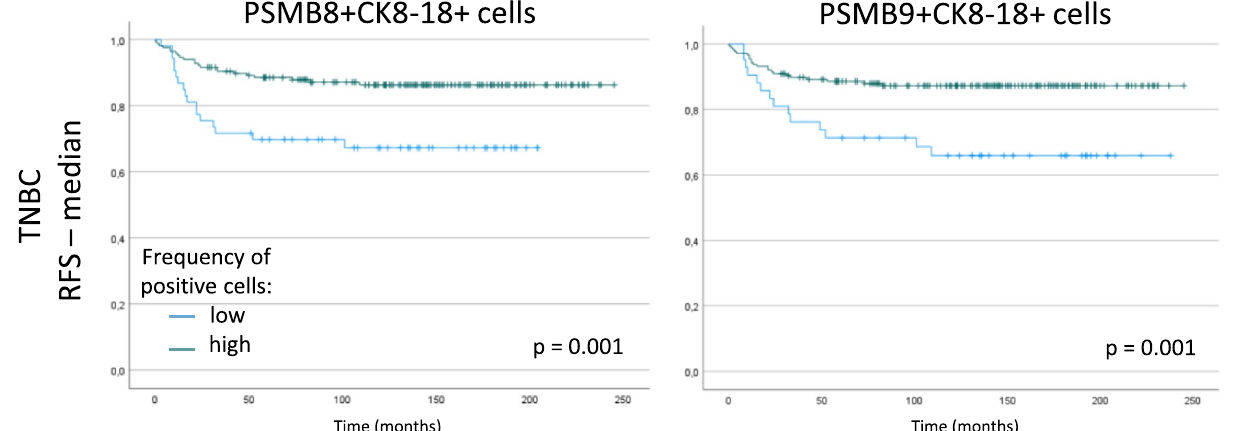
Figure 8. Protein expression of PSMB8 and PSMB9 in tumor cells is associated with better RFS in high-grade TNBC patients. RFS according to PSMB8 and PSMB9 expression by tumor cells (CK8-18+) of grade 3 TNBC samples. Samples were divided according to their median number of cells. The green and blue lines correspond to high and low frequency of positive cells, respectively. Statistical analyses by Logrank test: differences are considered statistically significant when p <